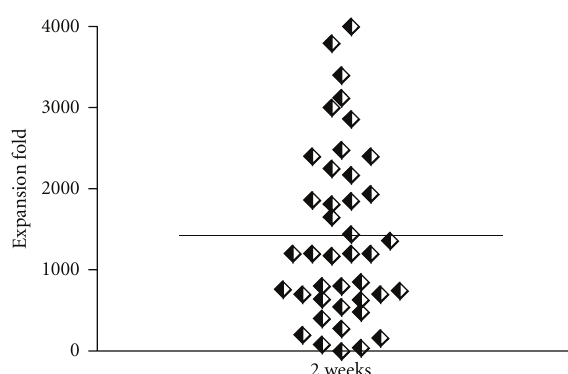
Figure 1: REP fold-expansion . During two weeks 41 TIL cultures (represented by single diamonds) reached a mean 1400 expansion